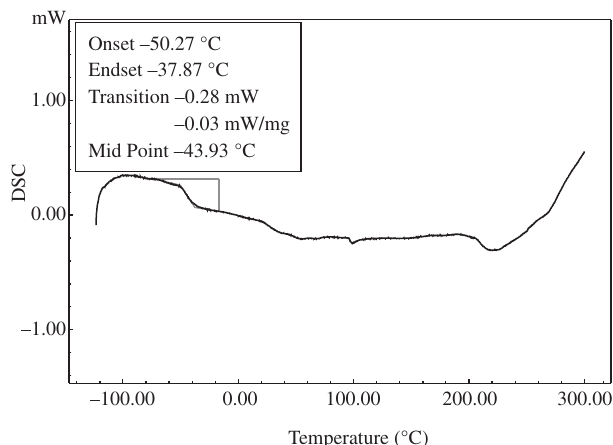
Figure 2. TGA thermogram of SBR-r (N rate of 10 °C/min)